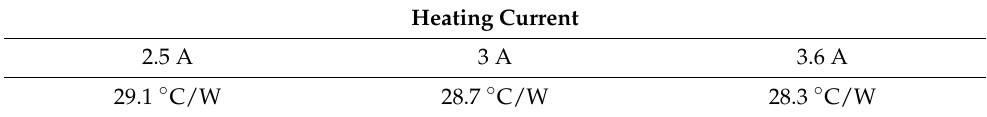
Table 4. Values of Zth obtained using V gs TSEP.